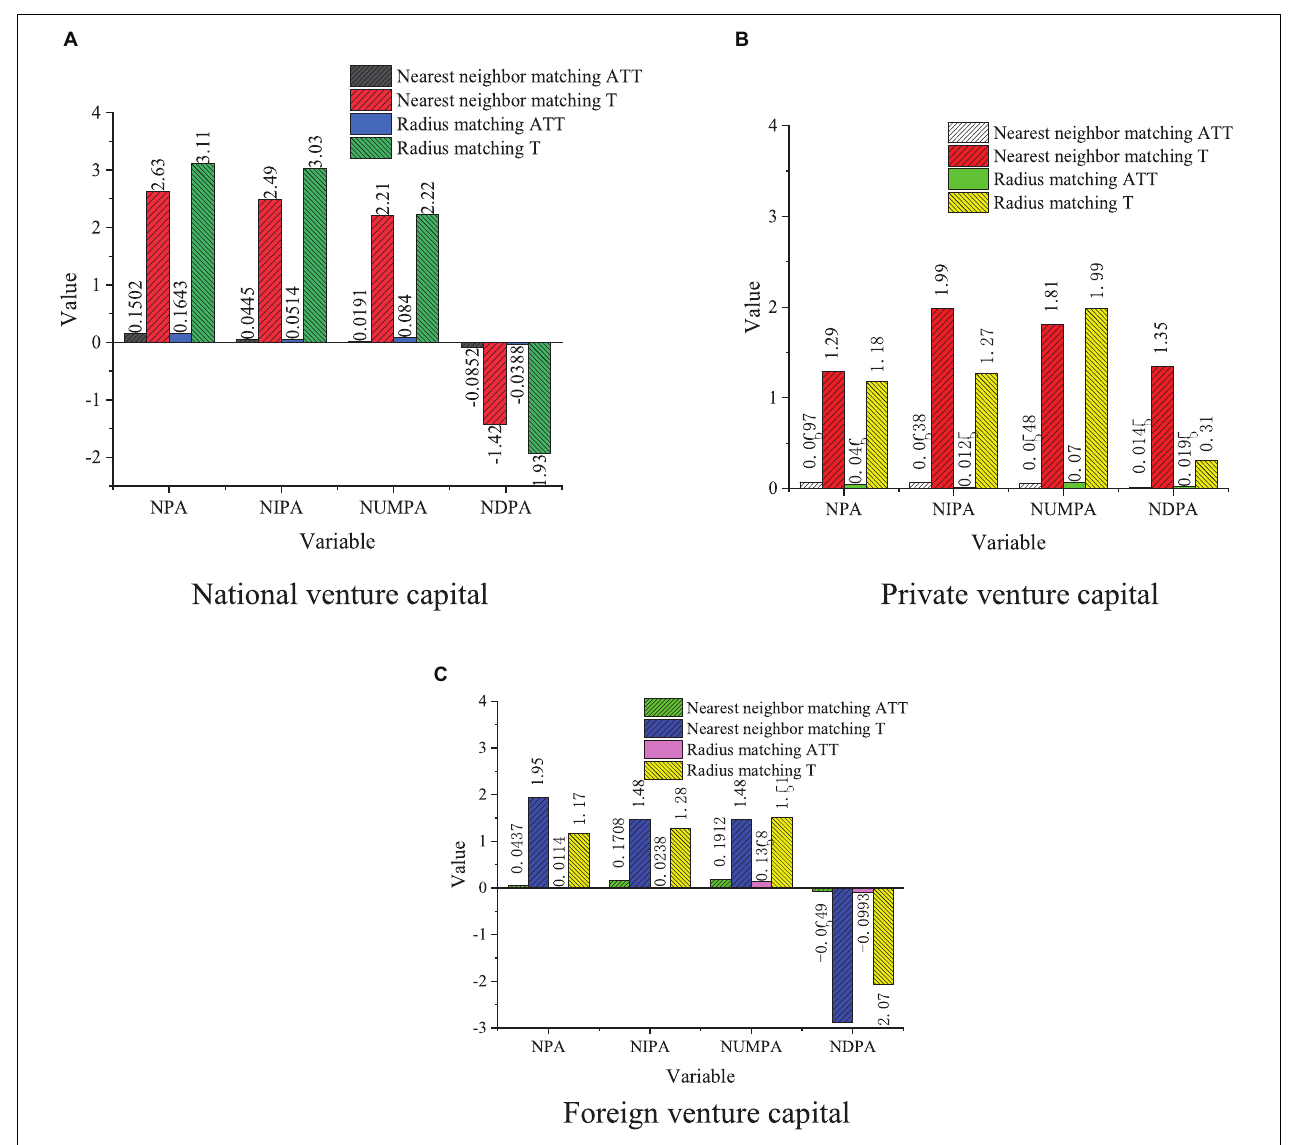
FIGURE 8 | Background impact of venture capital on startups performance. (A) National venture capital. (B) Private venture capital. (C) Foreign venture